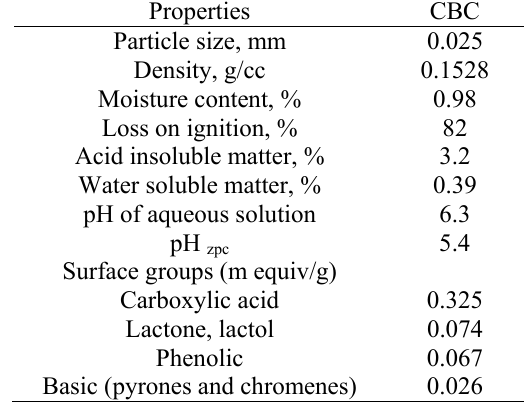
Table 1. Physical and chemical composition of the Cynodon dactylon adsorbent